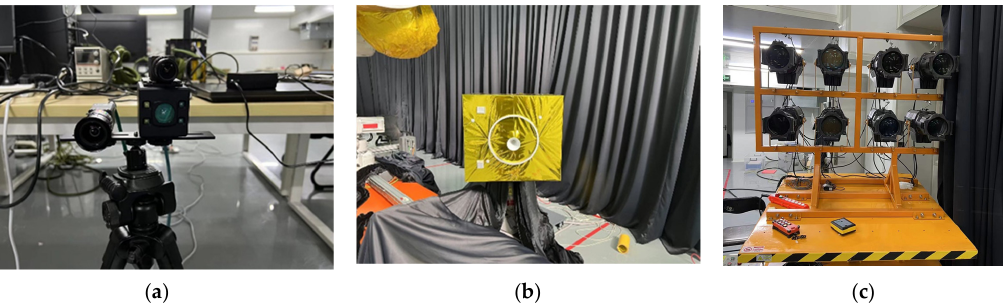
Figure 13. Schematic diagram of the ground verification system: ( a ) composite measurement system; ( b ) diagram of the non-cooperative target; ( c ) solar illumination simulator.